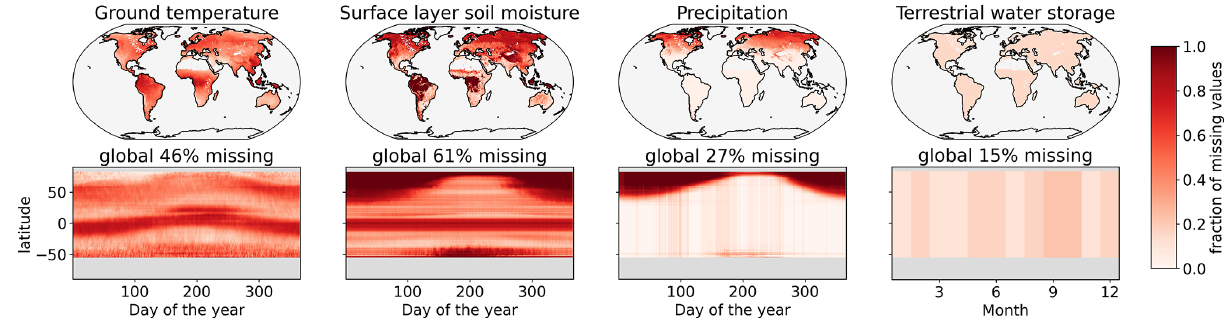
Figure 5. Fraction of missing data regarding ground temperature from MODIS, ESA-CCI soil moisture, GPM precipitation, and GRACE terrestrial water storage observations in the years 2003–2020. The upper panels show the fraction of missing data per land point on the ERA-5 grid, and the lower panels show fraction of missing values per latitude and day of the year. The data are down-sampled to daily values, with the exception of GRACE, which has monthly